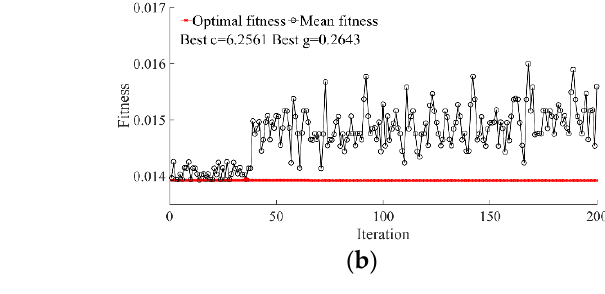
Figure 5. Optimization of SVR parameters. ( a ) SPA; ( b ) MCUVE.